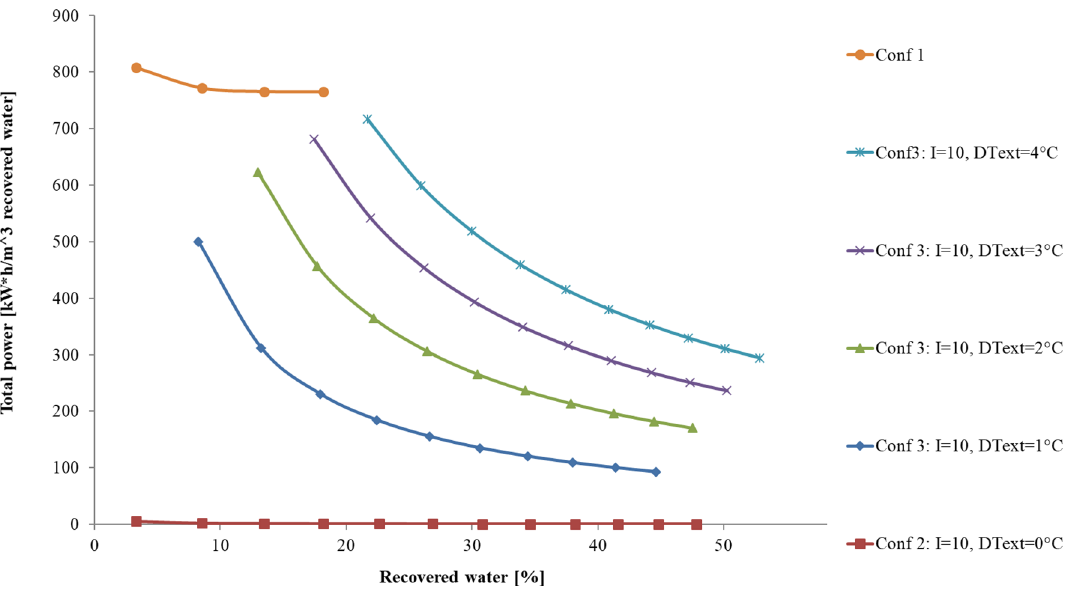
Fig. 11 Energy consumption in configuration 3 versus configuration 1 and 2 at increasing ΔT figure). Feed: RH = 100%, T = 45 °C, I =